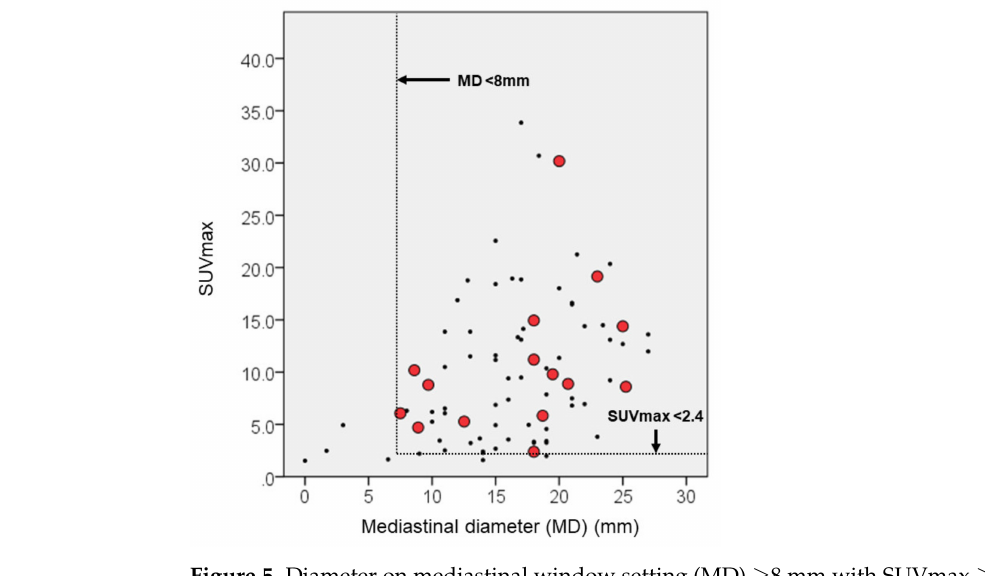
Figure 5. Diameter on mediastinal window setting (MD) ≥ 8 mm with SUVmax ≥ 2.4 could be a risk factor for lymph node metastasis. Red spots revealed cancer